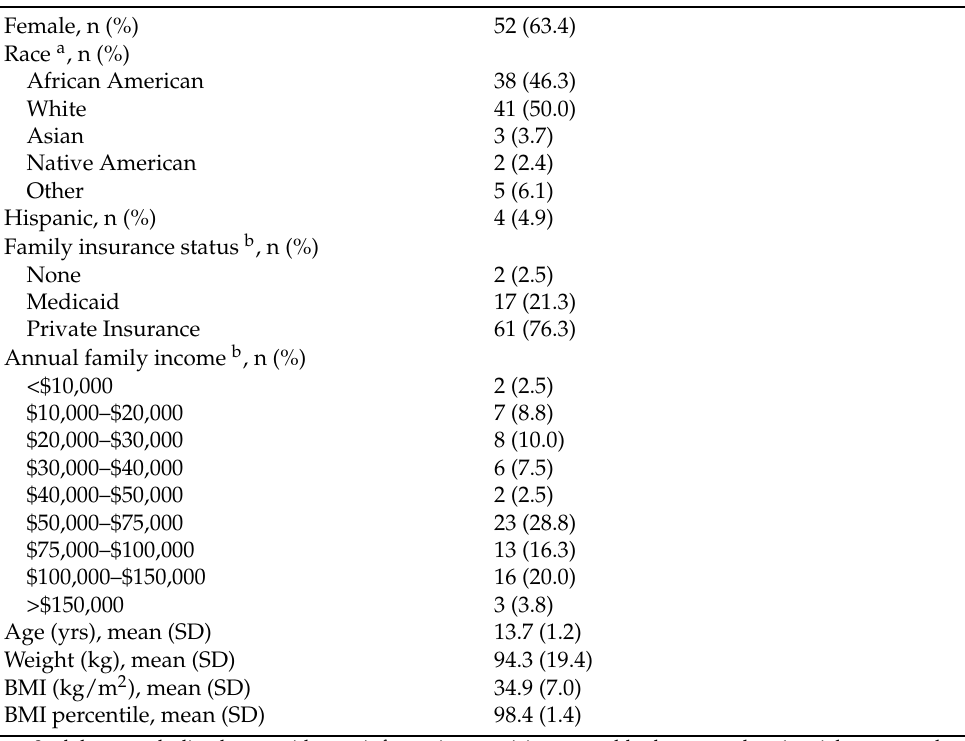
Table 1. Baseline demographics of adolescents (N = 82) enrolled in TEENS+.